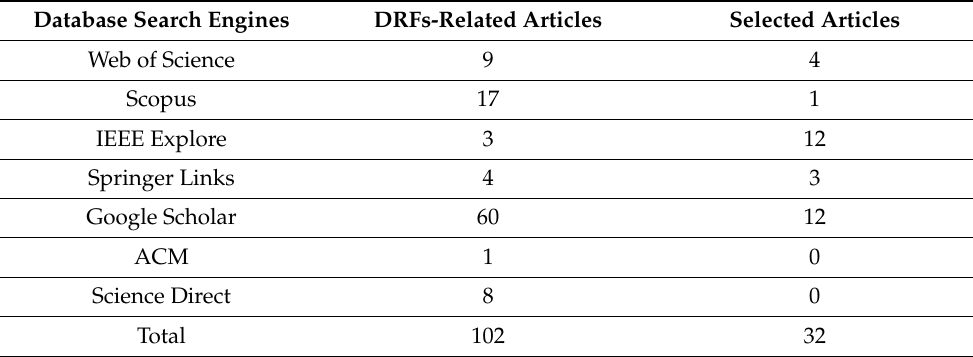
Table 1. Systematic Review